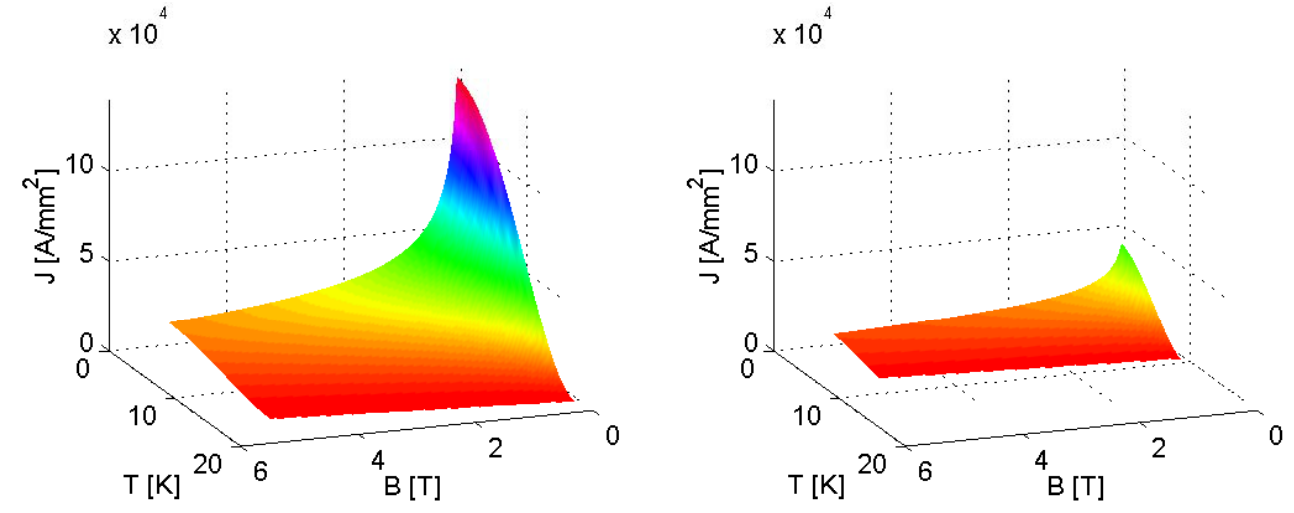
FIG. 6. (Color) Critical surfaces in B , T , J space for Nb